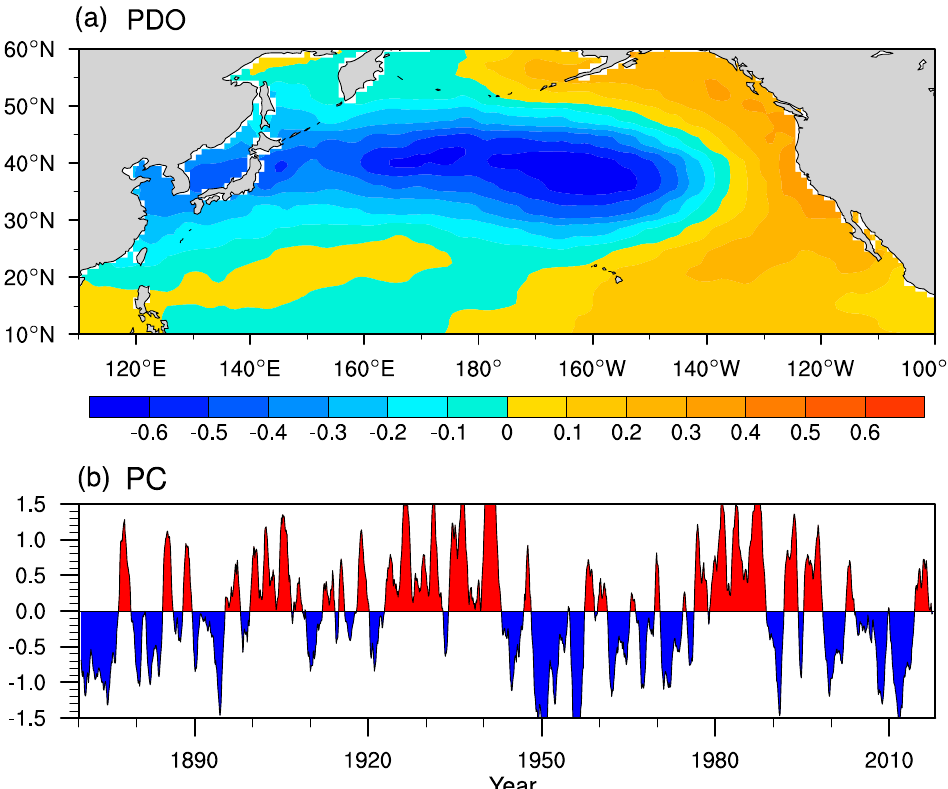
Figure 1. ( a ) Regressed sea surface temperature (SST) anomalies against the normalized PDO index defined as the first empirical orthogonal function (EOF) time series of the Pacific SST anomalies poleward of 20° N. ( b ) The normalized PDO index time series.